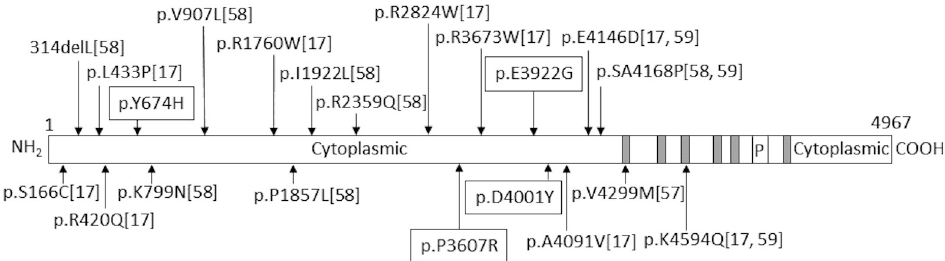
Fig 1. Schematic view of RYR2 mutations in long QT syndrome. Only those predicted to be damaging in silico are shown. The number in the parentheses indicates the reference number in the manuscript. Those with surrounding lines are the novel variants identified in this study. Gray boxes indicate the transmembrane region and “P” indicates the pore-forming